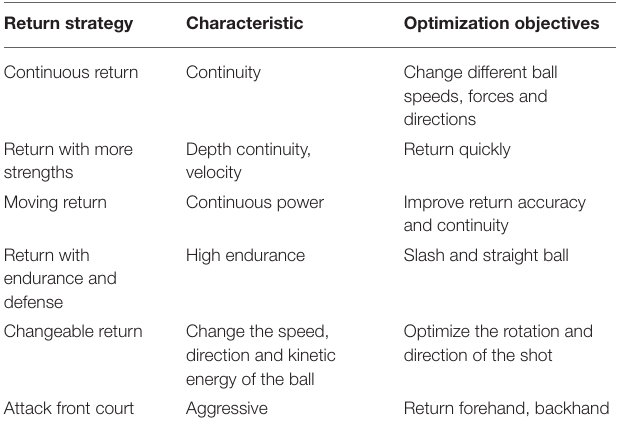
TABLE 1 | Analysis of tactical action characteristics of return ball of tennis sports